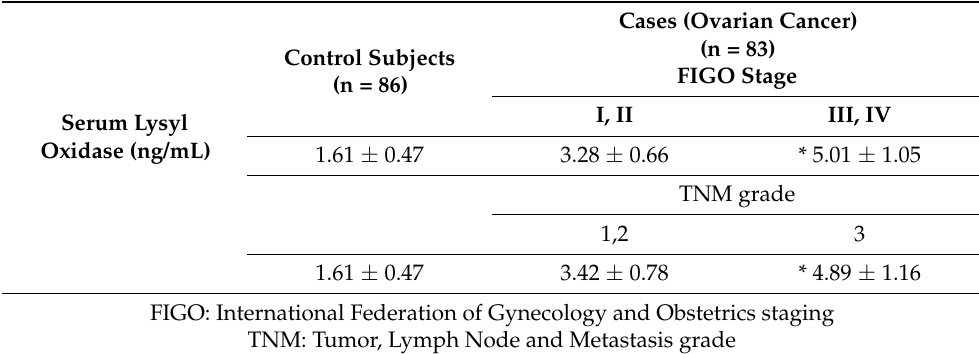
Table 2. Serum Lysyl Oxidase levels in ovarian cancer patients stratified based on clinical stages and its comparison with Control subjects.